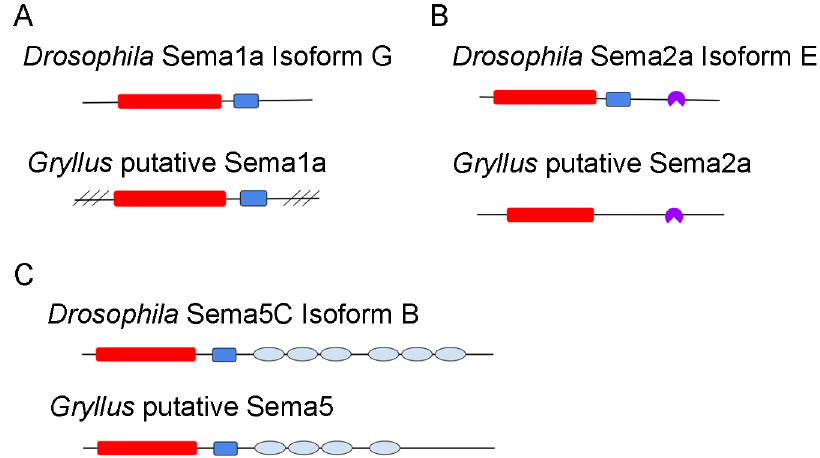
Fig 5. Semaphorin proteins predicted from the G . bimaculatus transcriptome share most of the functional domains found in Drosophila Sema proteins. A) The type, number, and order of protein domains was assessed using Drosophila Sema1a, isoform G (AGB92801) and the putative G . bimaculatus Sema1a (TRINITY_DN169697_c2_g1_i3) as queries in a conserved domain search. Both proteins possessed a sema domain (red rectangle) and a plexin repeat (blue rectangle). Diagonal lines indicate sequence missing from the N- and C-terminal ends of the predicted G . bimaculatus protein. B) The type, number, and order of protein domains was assessed using Drosophila Sema2a, isoform E (AAS64837) and the putative G . bimaculatus Sema2a (TRINITY_DN173773_c2_g2_i6) as queries in a conserved domain search. Both proteins possessed a sema domain (red rectangle) and an Ig domain (purple). Drosophila Sema2a, isoform E possessed a plexin repeat (blue rectangle) which was missing in G . bimaculatus . C) The type, number, and order of protein domains was assessed using Drosophila Sema5C, isoform B (ACZ94701) and the putative G . bimaculatus Sema5 (TRINITY_DN165105_c1_g2_i8) as queries in a conserved domain search. Both proteins possessed a sema domain (red rectangle) and a plexin repeat (blue rectangle). Drosophila Sema5c isoform B had six thrombospondin type 1 domains while the predicted Sema5 in G . bimaculatus had just four (light blue